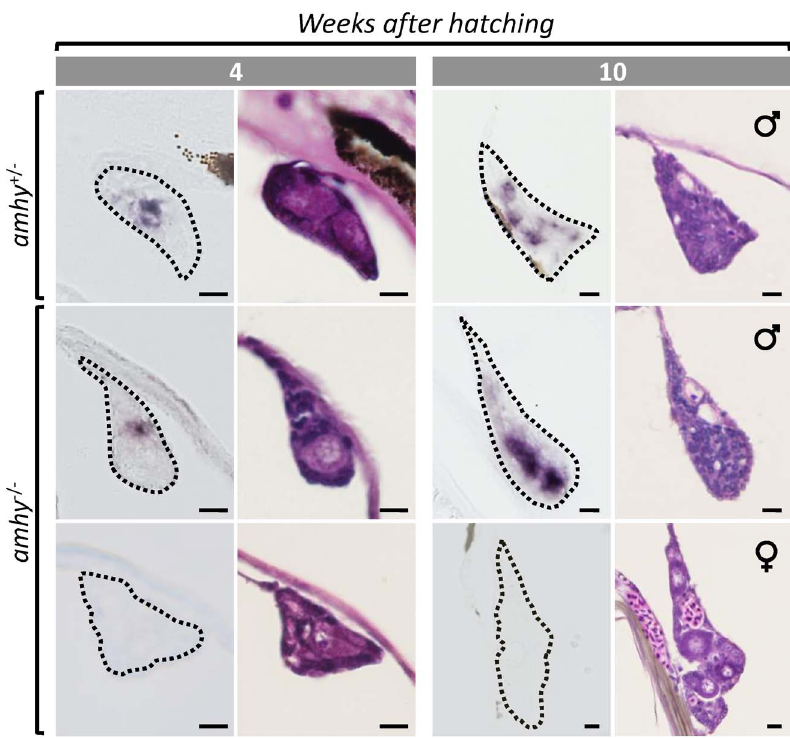
Figure 4. Spatial expression of amhy and amha mRNAs in differentiating gonads. Localization amhy and/or amha transcripts by ISH (left panels) and light microscopic histology (right panels) of gonads in 4 and 10 week old larvae reared at 25 u C. Transcripts were detected in all amhy + / 2 genotypes (presumptive amhy and/or amha signals) and in about half of the amhy 2 / 2 genotypes ( amha signals). At 10 wah, the expression was detected in developing testis but not in developing ovaries. Scale bars indicate 10 m m.